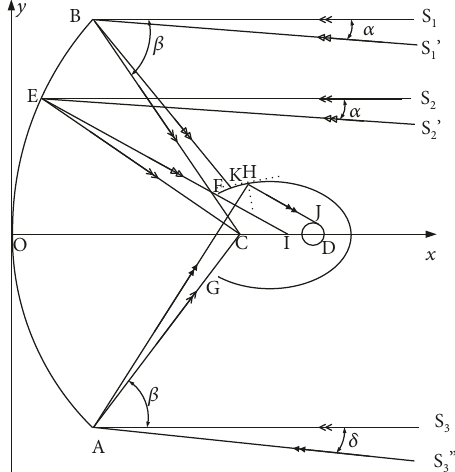
Figure 2: Sunlight trace in a PTC with an elliptical cavity tube receiver by considering the tracking error angle α under the rectangular coordinate system.